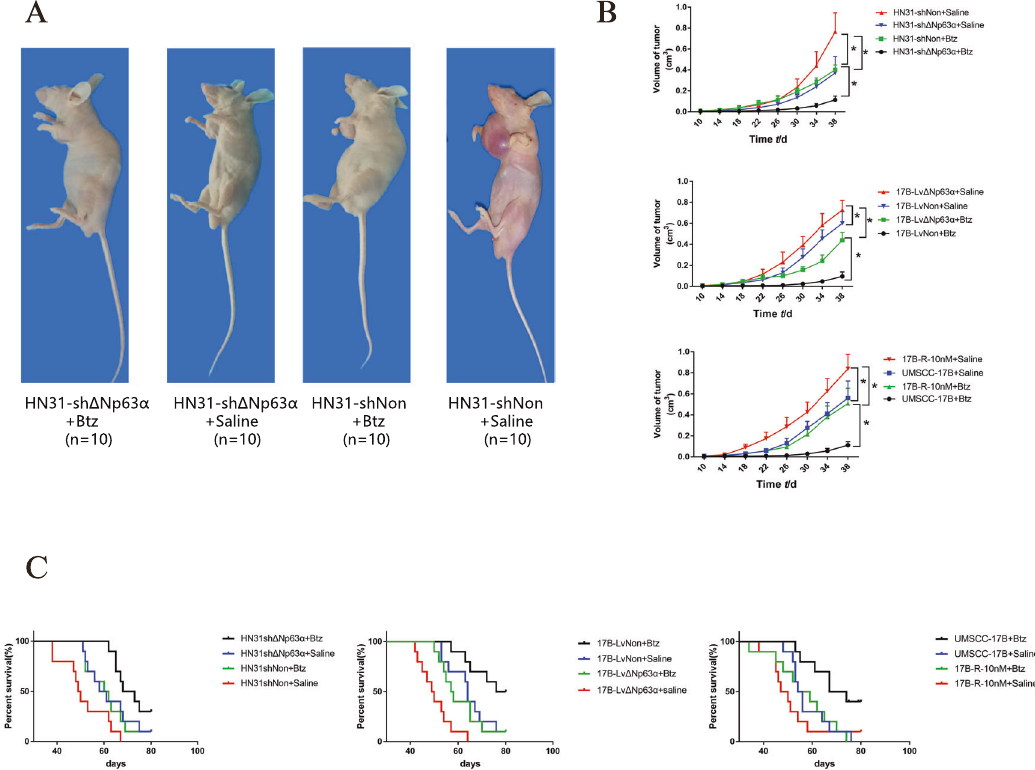
Fig. 3 Δ Np63 α exerts a promotional effect on tumorigenesis and drug-resistance in vivo. A . BALB/c nude mice subcutaneous HNSCC tumors were given tail vein injections of bortezomib (Btz) or saline. The injection dose of bortezomib injection is 0.3 mg/kg, and they were injected every three days for 6 consecutive weeks. Mice of groups (HN31-sh Δ Np63 α + Btz, HN31-sh Δ Np63 α + Saline, HN31-shNon + Btz, and HN31-shNon + Saline) of the 38th day were shown above. B . Larger diameters and smaller diameters of the tumors were measured and the volume of the tumors was calculated in the following groups (HN31-sh Δ Np63 α + Btz, HN31-sh Δ Np63 α + Saline, HN31-shNon + Btz, HN31- shNon + Saline, 17B-Lv Δ Np63 α + Btz, 17B-Lv Δ Np63 α + Saline, 17B-LvNon + Btz, 17B-LvNon + saline, 17B-R-10nM + Btz, 17B-R-10nM + Saline, 17B-P + Saline, and 17B-P + Btz). * P < 0.05. C . Comparisons of survival curves were performed in these